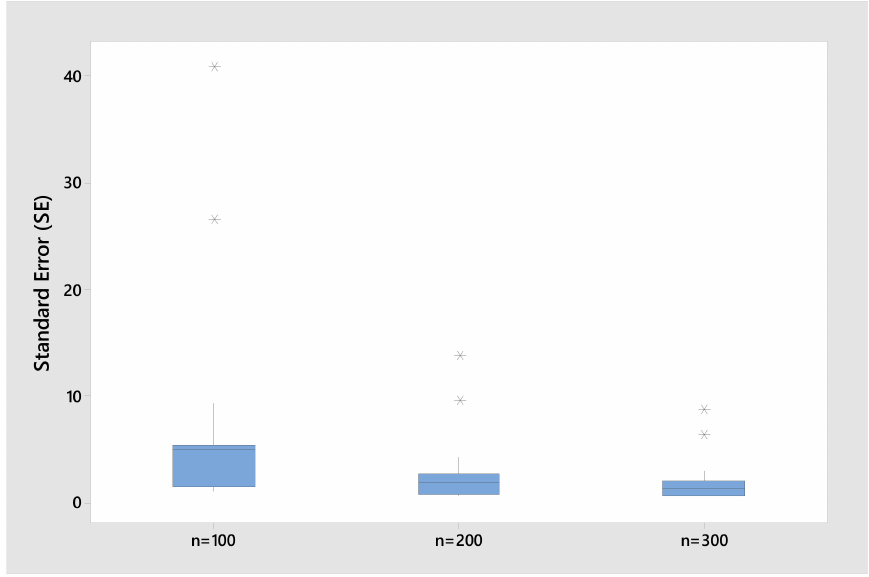
Figure 2. Boxplot of Standard Error (SE) for different sample